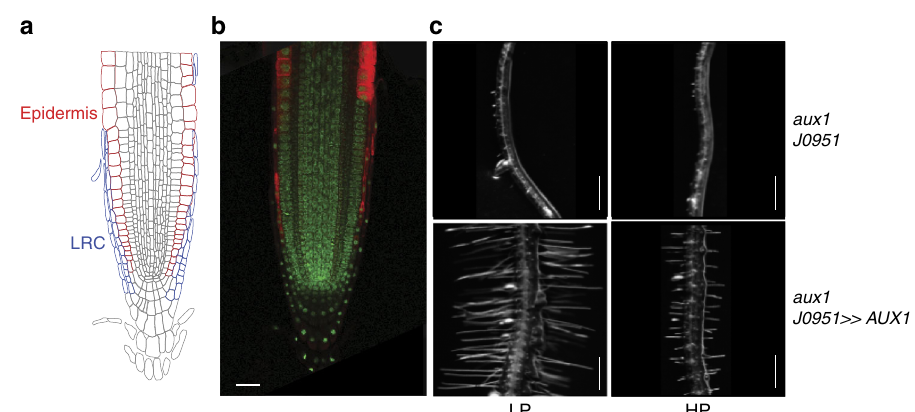
Fig. 3 Expressing AUX1 in LRC and epidermal cells can restore aux1 root hair defect under low P. a The schematic diagram of the Arabidopsis root apex. b Confocal image showing AUX1 expression in lateral root cap and epidermal cells in aux1-22 J0951»AUX1 line. Scale bar = 20 µ m. c Representative images showing root hair growth in the driver line aux1-22 J0951 and aux1 -22J0951»AUX1 lines under low (LP) or high P (HP). N = 3, scale bar =